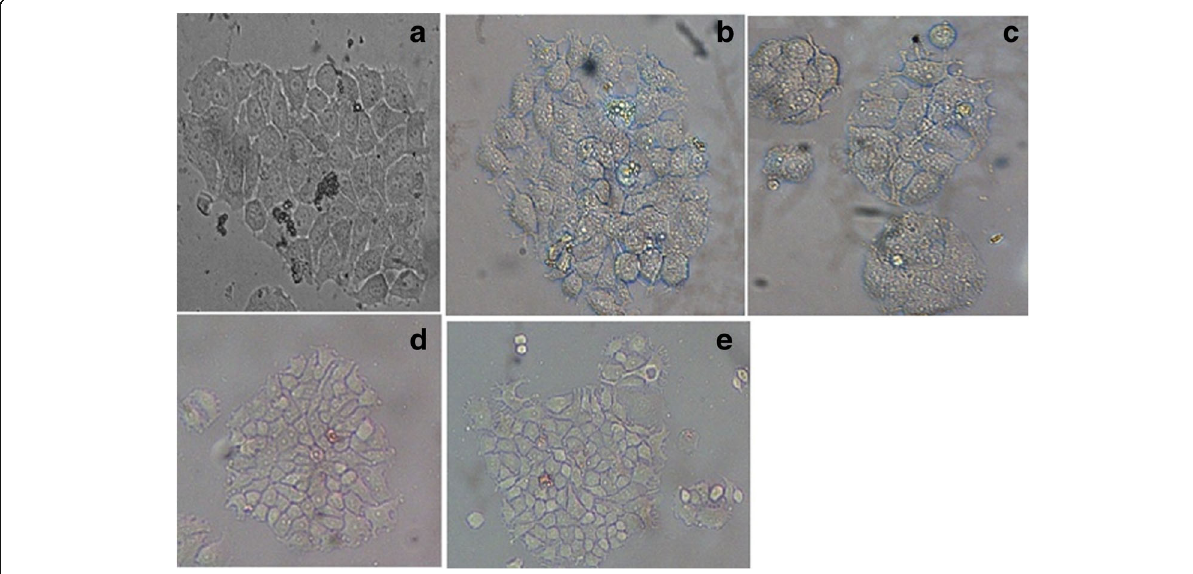
Fig. 1 Photomicrographs of control cells ( a ), silymarin ( b ), piperine ( c ), lysergol ( d ), and fulvic acid ( e ) treated MCF-7 cells